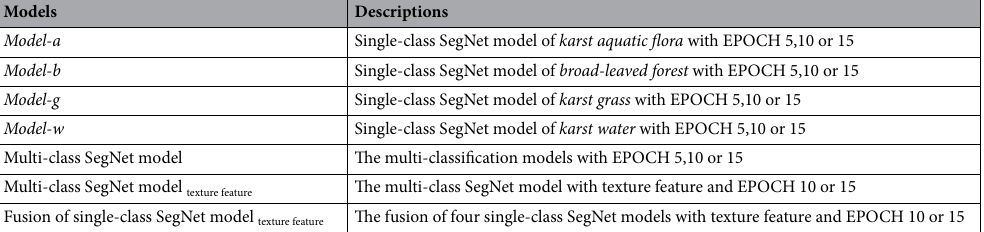
Table 2. Description of the SegNet models with different EPOCH values.